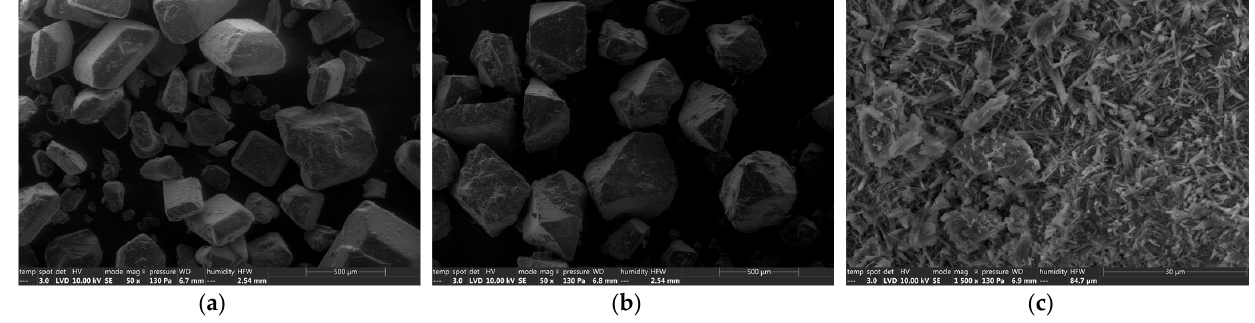
Figure 2. Scanning electron microscope (SEM) analyses of different sweeteners. ( a ): sucrose crystals with geometric shape ×50, ( b ): maltitol crystals with geometric shape ×50, ( c ): aggregated fi ne sorbitol fl akes ×500.